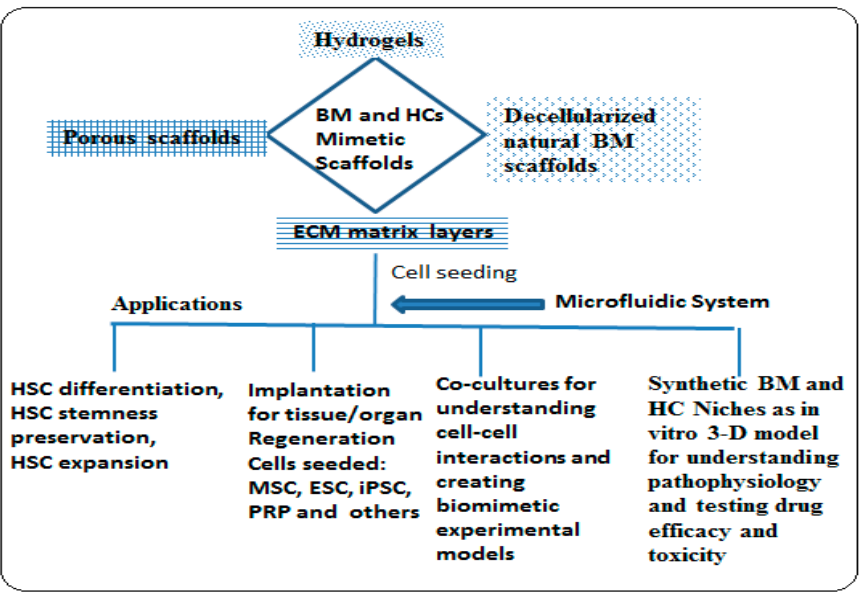
Figure 6. Schematic of applications of various types of scaffolds in BMTE and HCTE.